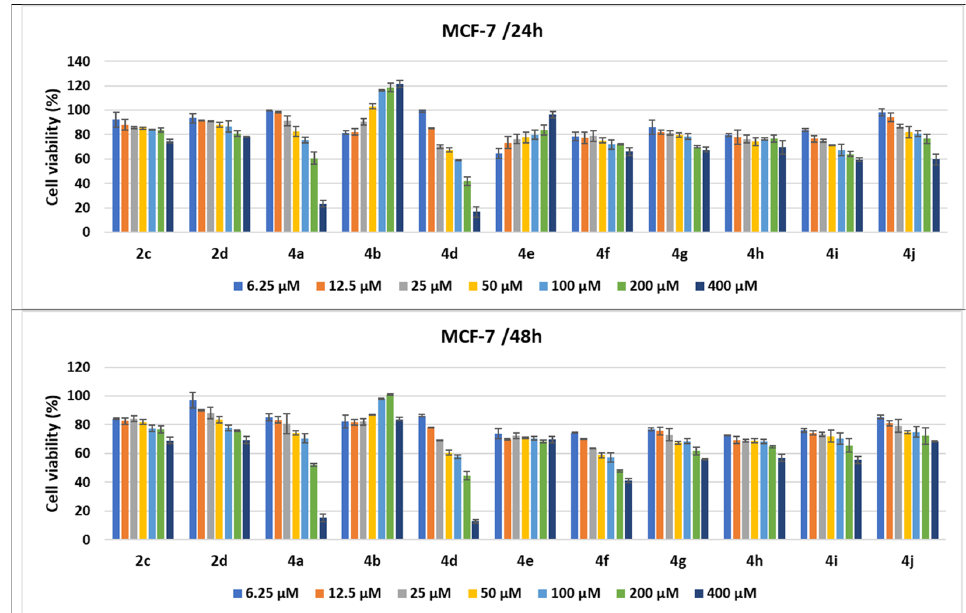
Figure 11. Antitumor effect of pyrrole derivatives against MCF-7 breast cancer cells. The viability of the MCF-7 cells was measured after treatments with scalar concentrations of pyrrole compounds for 24 or 48 h and compared to that of untreated control cells. Data are expressed as the mean value ± standard deviations (SDs) of three different experiments ( n = 3 ).